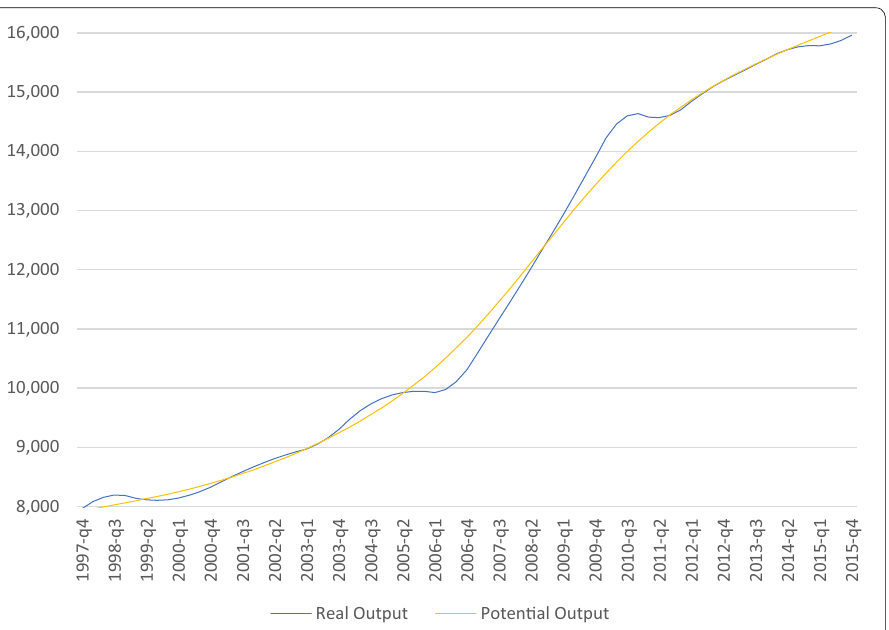
Fig. 1 Real and potential outputs of the Lebanese economy (QI‑1998 to QIV‑2015). Source : Performed by author using the Hodrick Prescott filter based on data for real GDP collected from World Bank